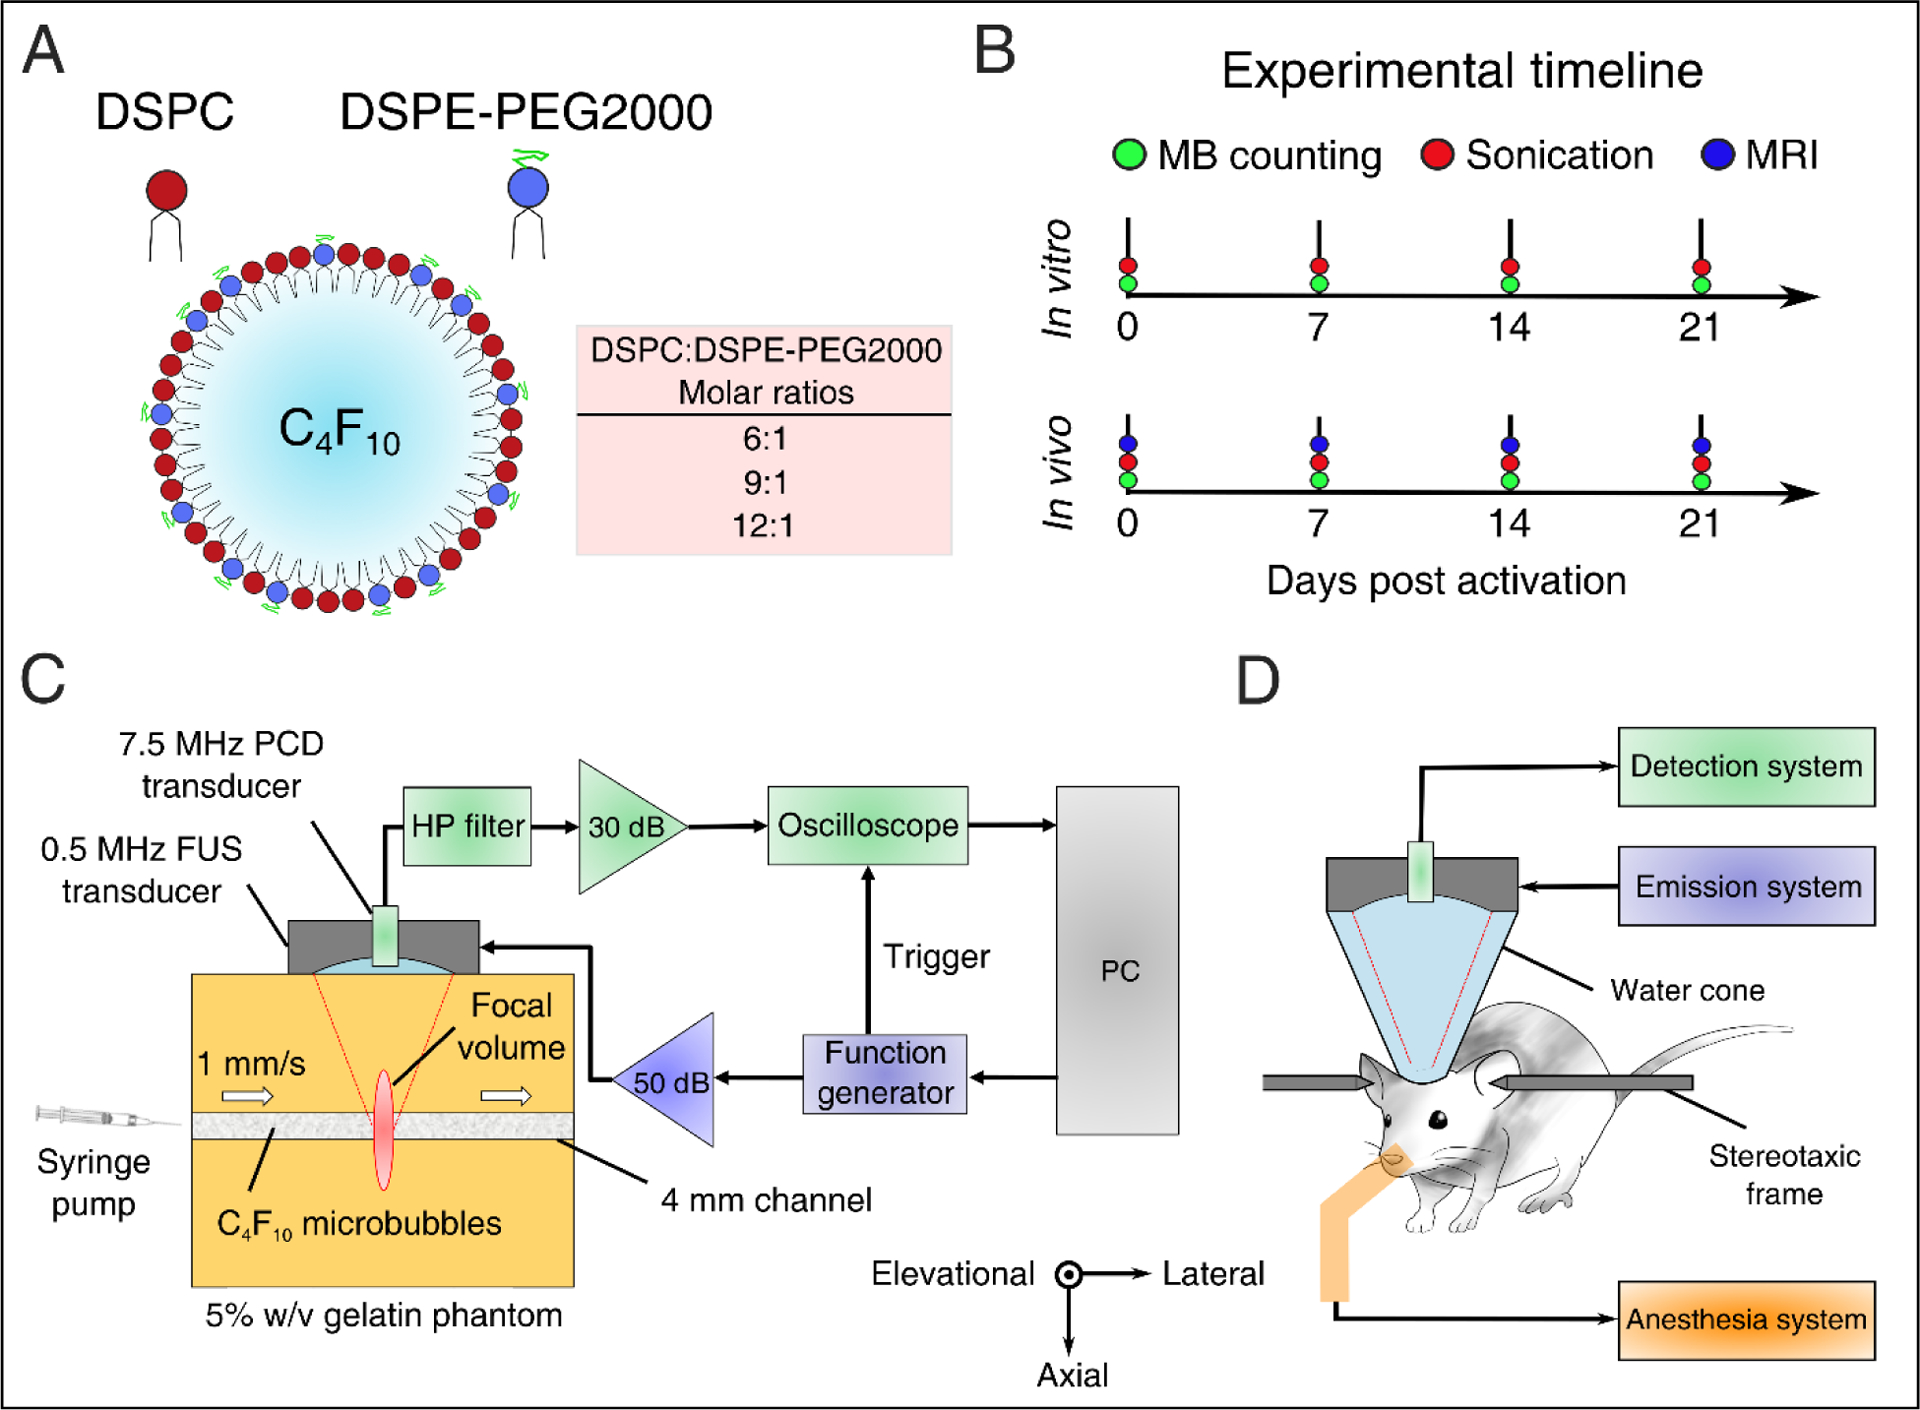
Experimental outline and setups.(A) Microbubble formulation. DSPC and DSPE-PEG2000 were mixed at different lipid molar ratios to produce microbubbles of variable shell stiffness and viscosity. (B) Experimental timeline for estimating microbubble stability in vitro and in vivo. (C) In vitro experimental setup using a 5% w/v tissue-mimicking phantom. (D) In vivo experimental setup for non-invasive blood-brain barrier opening in mice. Abbreviations: FUS – focused ultrasound; PCD – passive cavitation detection; HP – 1.2-MHz high-pass.